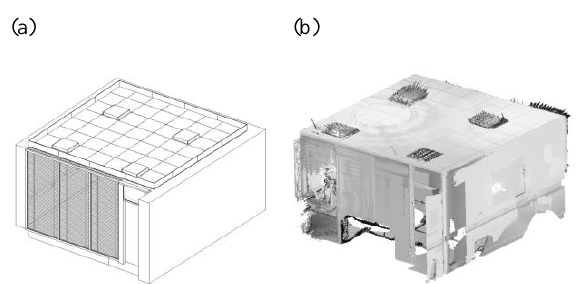
Figure 5 . Visualization of (a) as-planned model, and (b) as- built model, from dataset 3